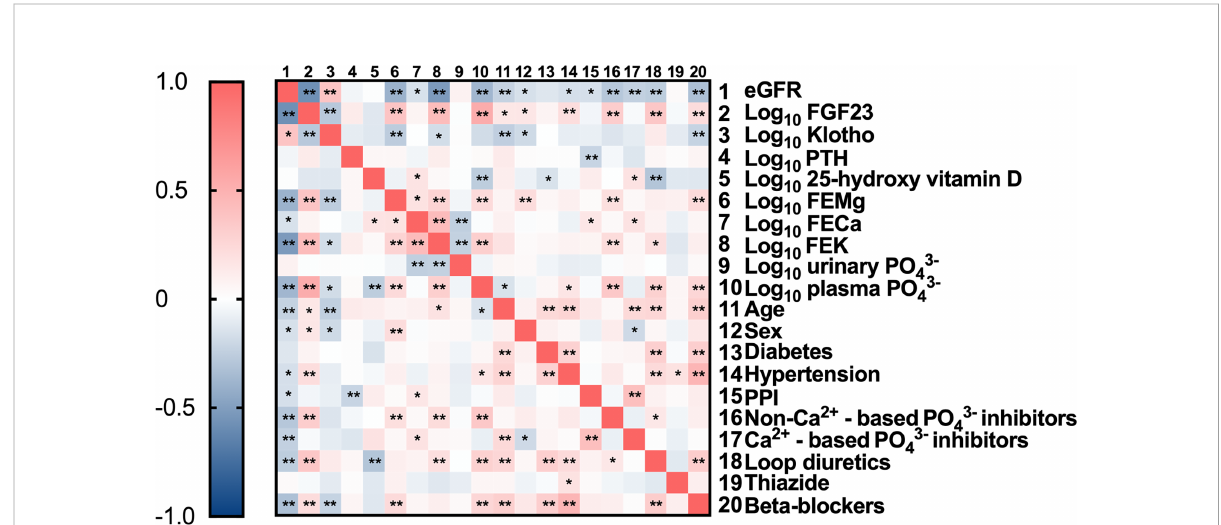
FIGURE 2 Correlation matrix with relevant parameters included. Data are the outcomes of bivariate analysis; *Correlation is signi fi cant at the 0.05 level; **Correlation is signi fi cant at the 0.01